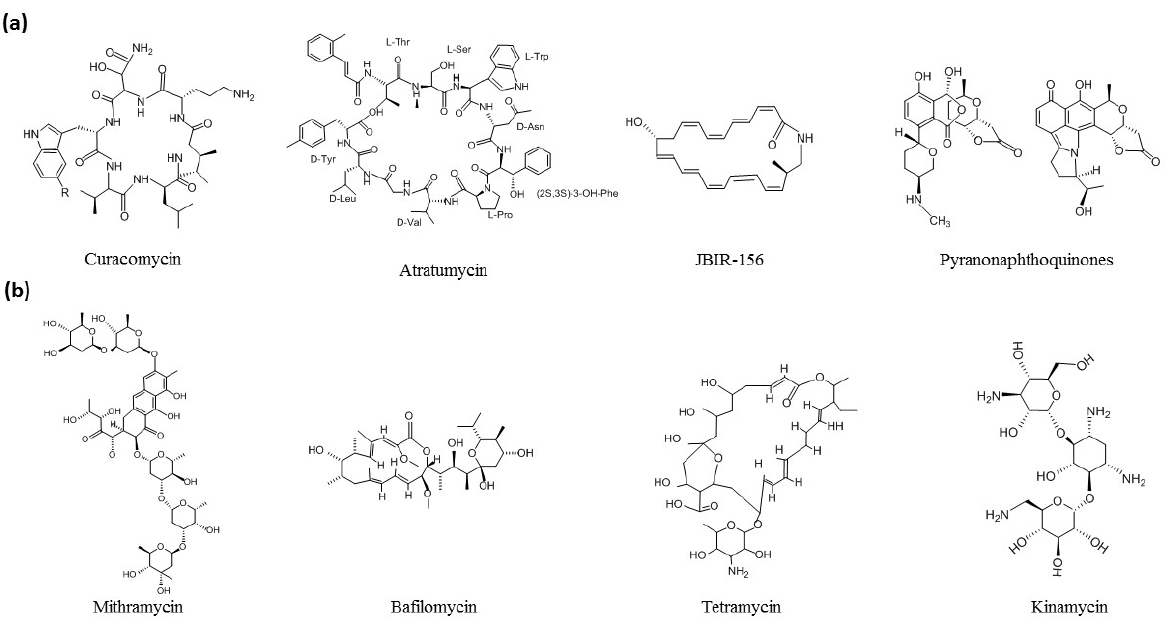
Figure 2. Illustration of chemical structures of notable compounds discovered through genome-directed approaches. ( a ) Novel compounds. ( b ) Over expressed compounds.